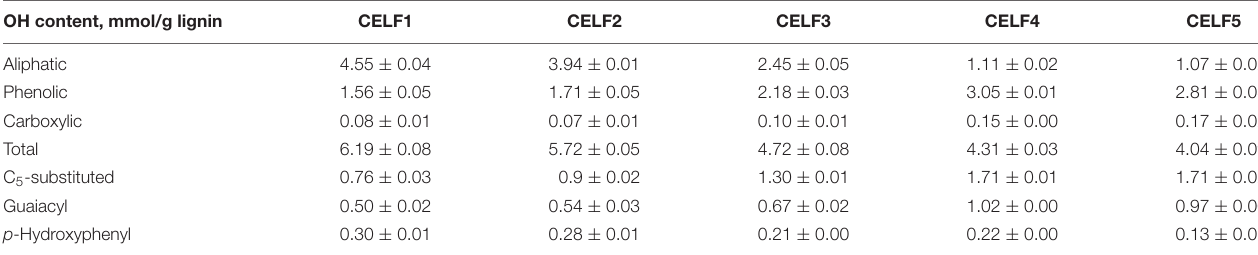
C 5 -substituted p -Hydroxyphenyl The error values were obtained from standard deviation of duplicate